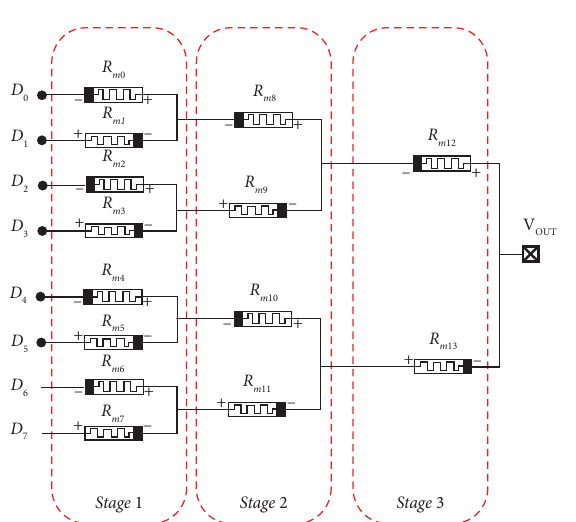
Figure 26: Te DAC of two memristor connected in opposite direction [68].